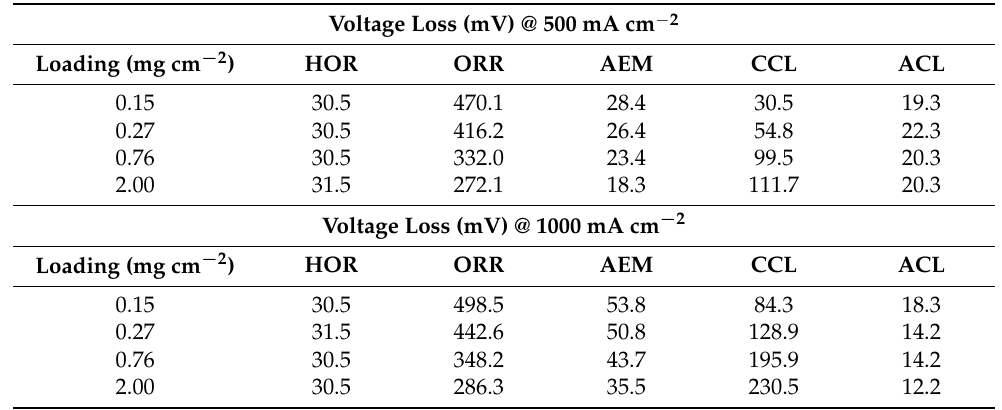
Table 3. A quantitative comparison of the contributions of the cell components to the overpotential distribution at current densities of 500 and 1000 mA cm − 2